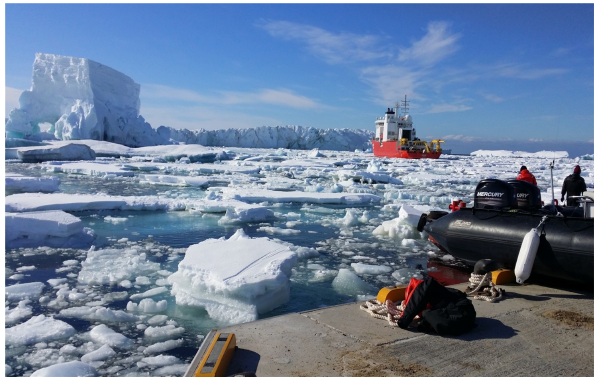
Figure 1. Drifting ice, including icebergs and mobile sea ice, around the Jang Bogo Antarctic Research Station (JBARS), pho- tographed on 29 January